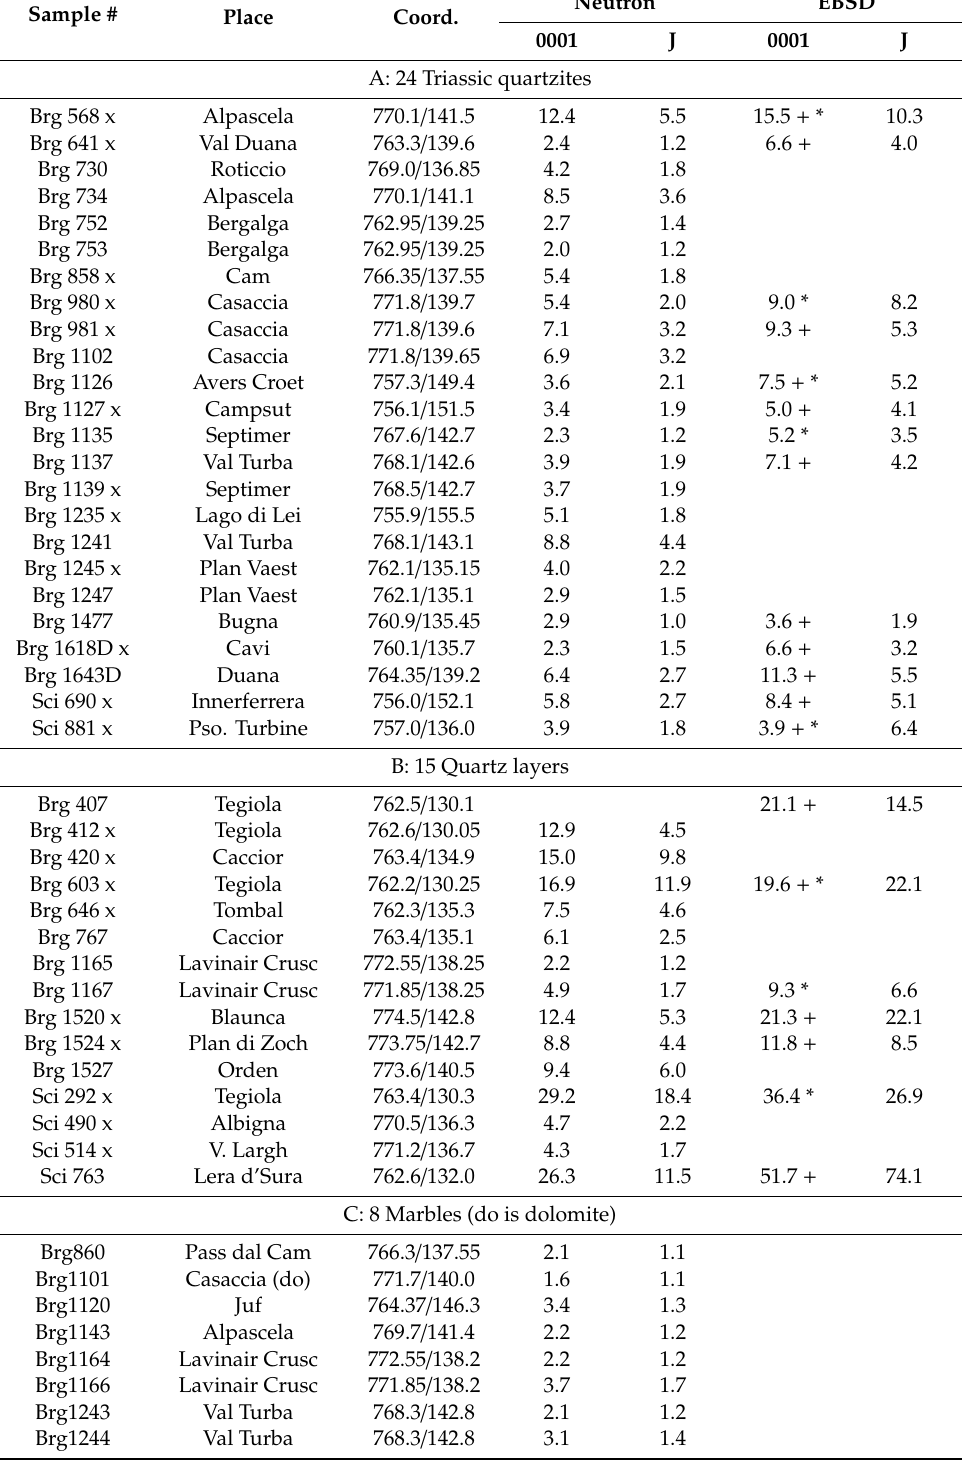
Table 1. List of samples with location, Swiss coordinates (in km) and (0001) pole figure maxima (in multiples of a random distribution) as well as texture index J for neutron and EBSD textures. The x after sample number indicates that optical microstructure is displayed in Figures 3 and 4; D indicates Dubna data. + in the electron backscatter di ff raction (EBSD) column indicates that map is displayed in Figure 11, and * that comparison of neutron and EBSD pole figures is shown in Figure 12. Additional samples are listed in Table